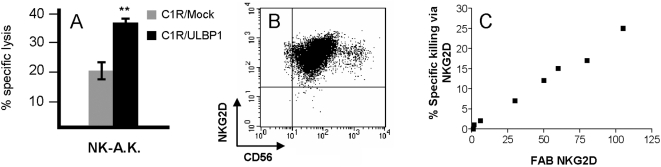
NKG2D-mediated killing directly correlates with the strength of NKG2D expression.Killing rates of C1R cells transfected with an empty vector (C1R/Mock, gray bars) or with the NKG2D-ligand ULBP1 (C1R/ULBP1, black bars) by a representative bulk NK culture NK-A.K. Effector-to-target ratio was 5∶1. ** indicates P value<0.01. (B) NKG2D staining phenotype on a representative bulk NK culture NK-A.K. (C) Correlation between NKG2D expression (X-axis) and percent specific killing via NKG2D (Y-axis). FAB stands for fold above background, which is the ratio between specific and background staining intensity. The percent specific killing via NKG2D is the difference between killing of C1R/ULBP1 to C1R/Mock by the effector cells. Each black square represents the mean values of a different NK bulk culture tested three times. Correlation was tested statistically with Spearman's correlation.